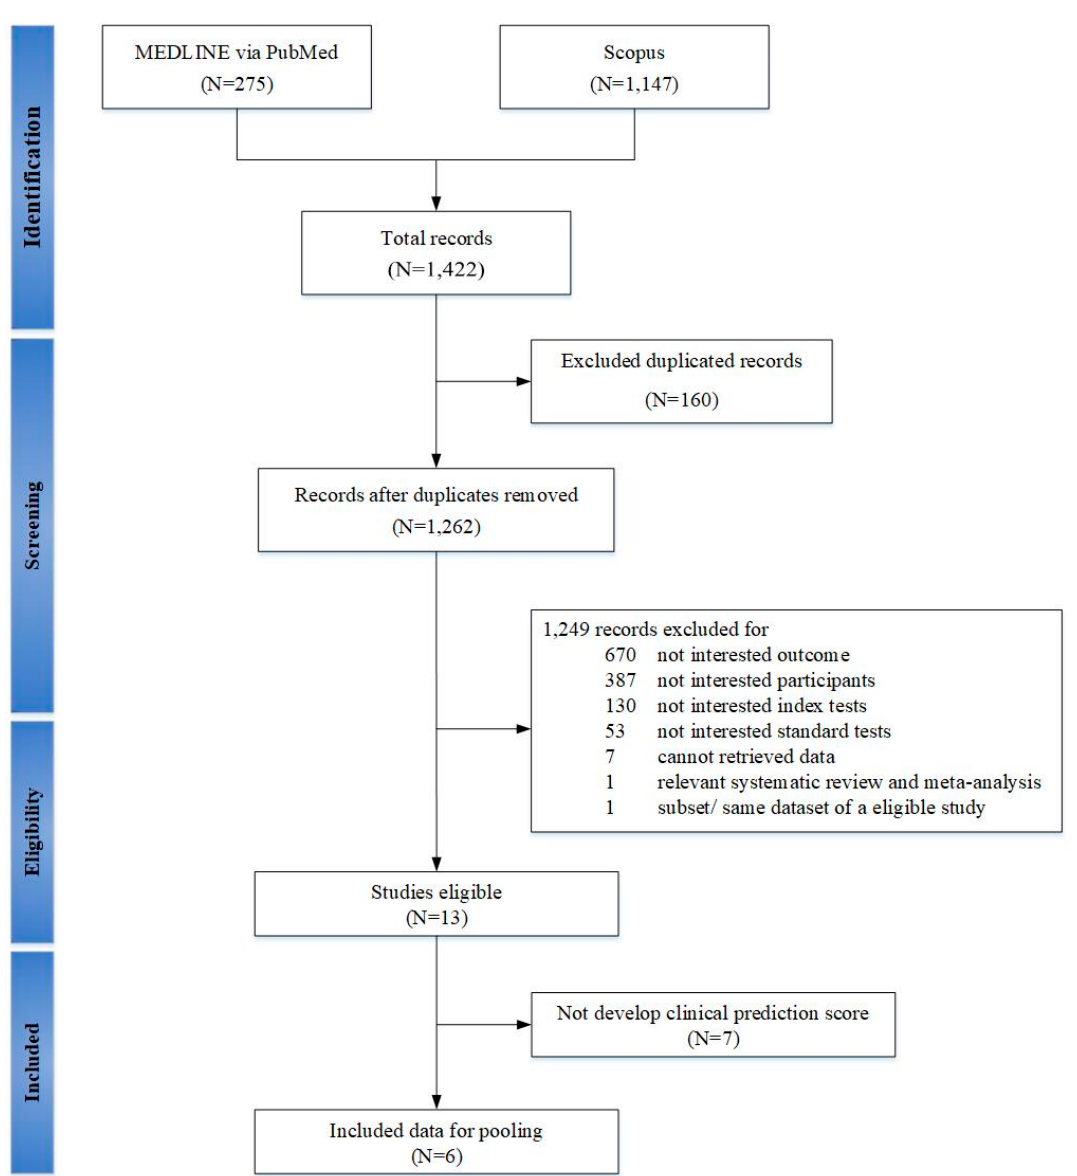
Figure 1. PRISMA flow chart of selecting studies for systematic review and meta-analysis with prediction model in gestational obstructive sleep apnea.